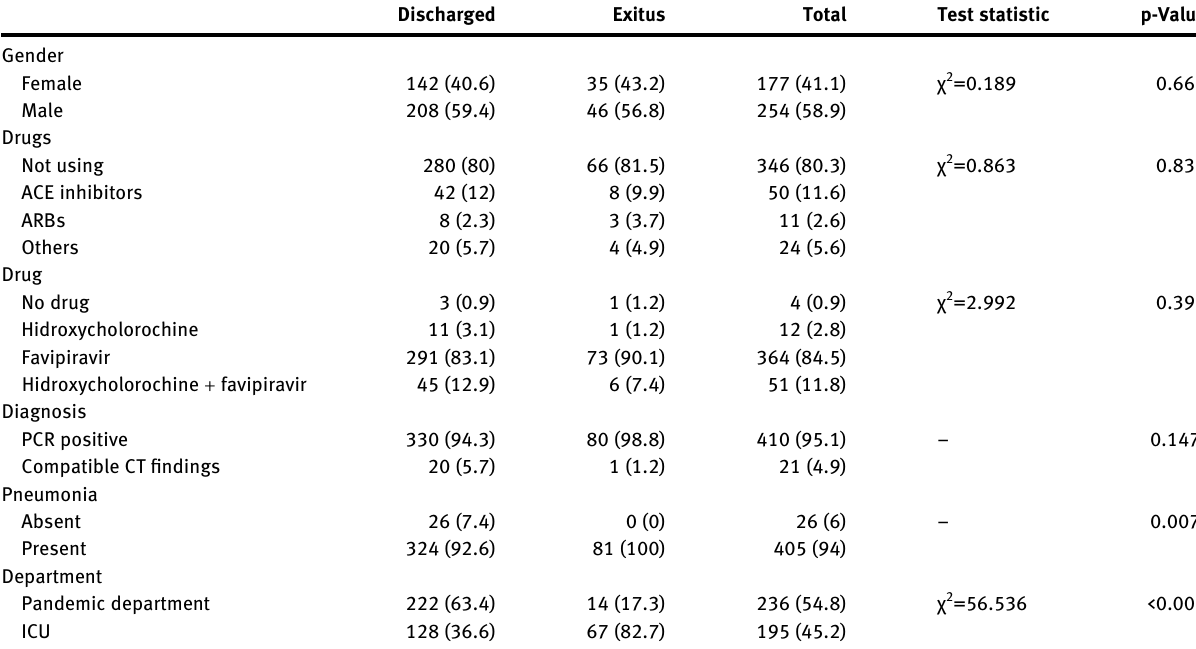
Table  : Comparison of categorical variables by groups.